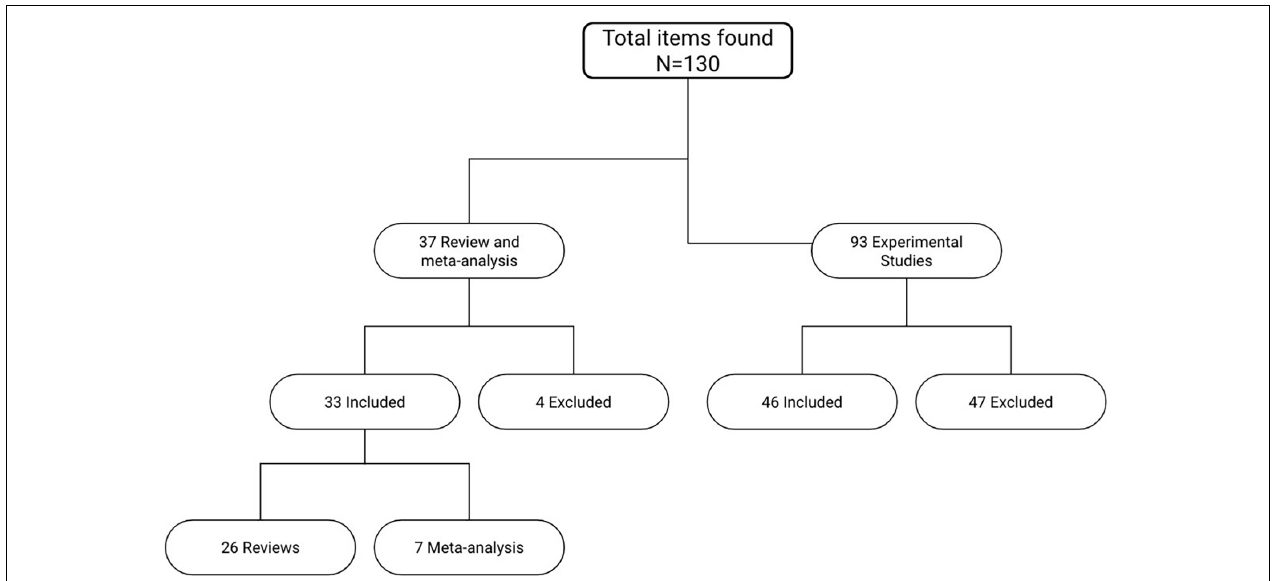
FIGURE 1 | Flowchart of data gathering